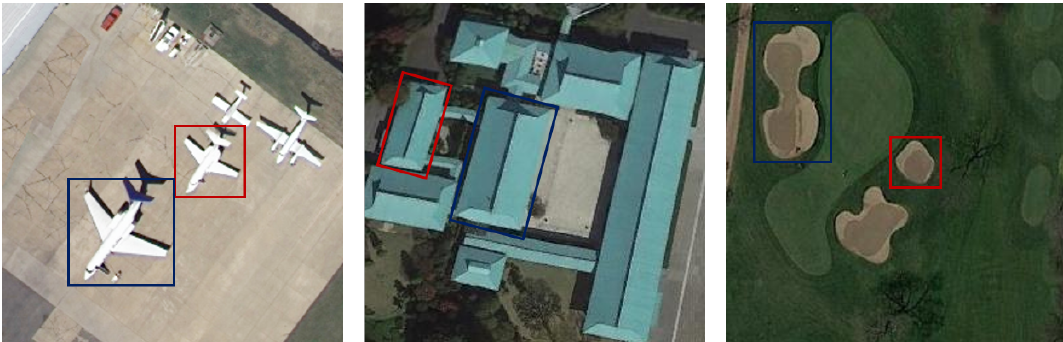
Figure 1. Cross-scale internal information reproducibility of remote sensing images. The information inside the same picture (small-scale information in the red frame) can be found in other places (large-scale information in the blue frame) for the existence of different